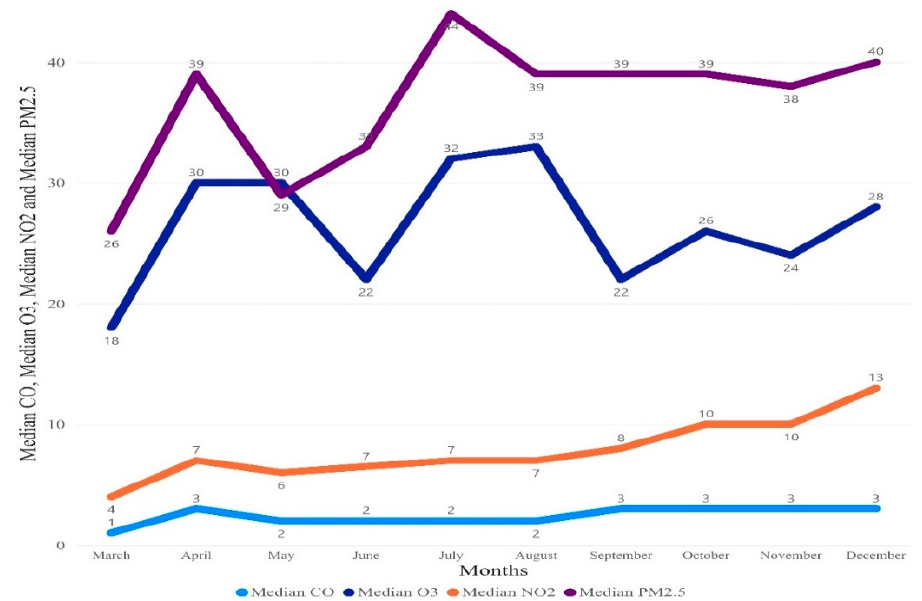
Figure 4. Monthly median distribution of the pollutant parameter.